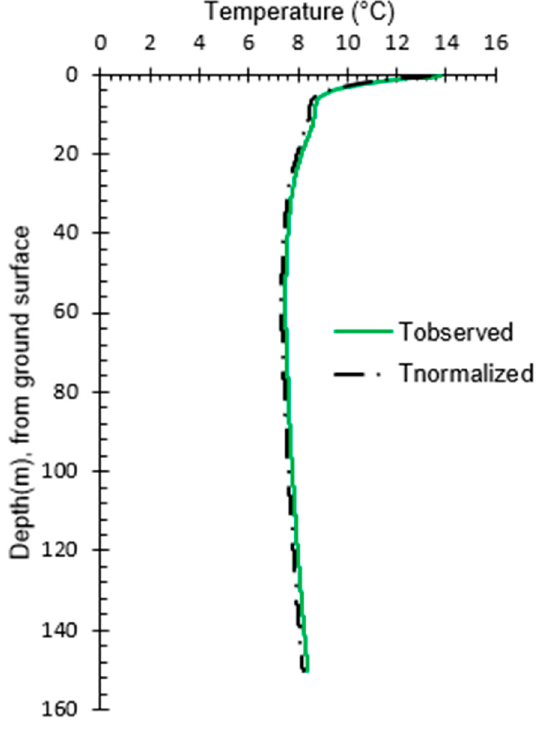
Figure 8. Normalized ( T normalized ) and measured ( T observed ) temperature profiles at the INRS experi- mental site.